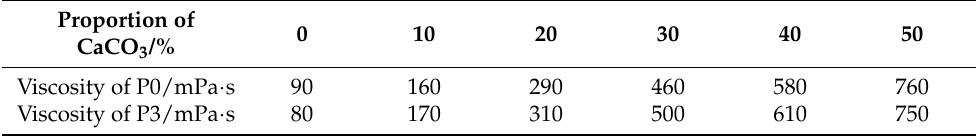
Figure 7. Bending strength of samples with different ratios of PCE. It can be observed from Figure 7 that the prepared repair material had a higher bend- ing strength, and that the strength in the early stage was higher. At three days, the bending strength reached up to 19~20 MPa. However, the bending strength slowly developed in the later stage, and its strength reached up to 27~30 MPa at 28 days. The flexural strength